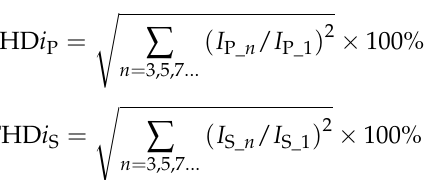
i S Figure 7. Main voltage and current waveforms of no backflow power.